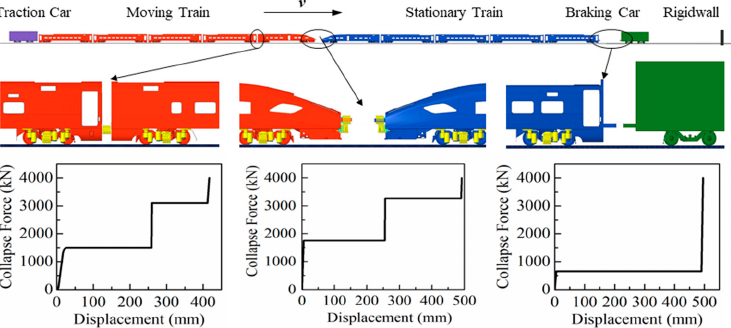
Figure 6. Energy-absorbing and simplified load – displacement curve.